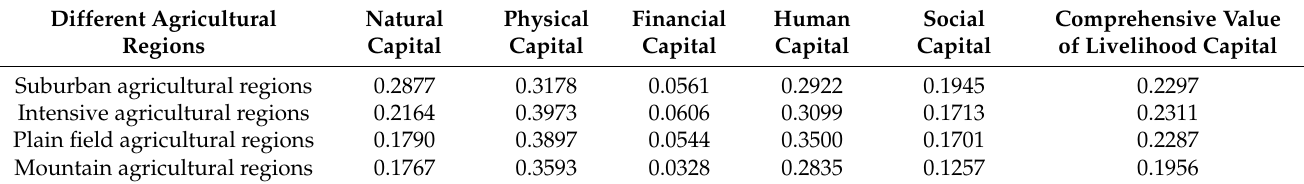
Table 4. Comparison of livelihood capital per rural household in different agricultural regions.